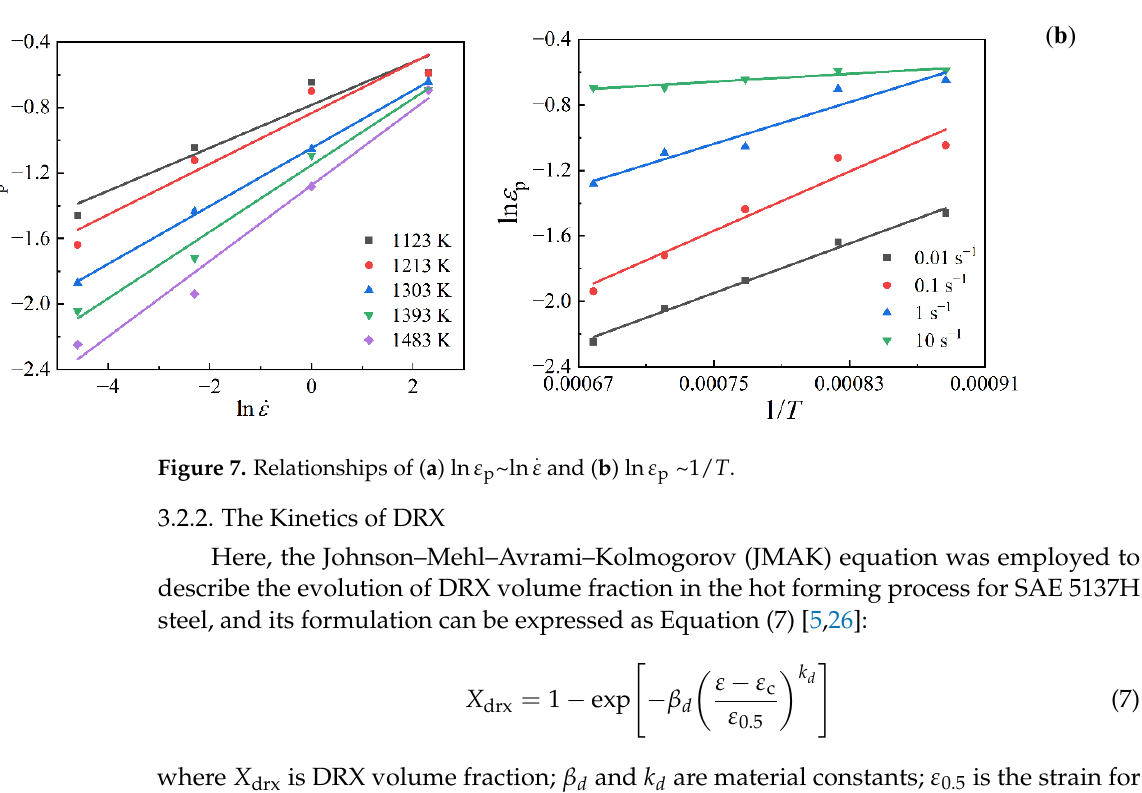
Figure 7. Relationships of ( a )